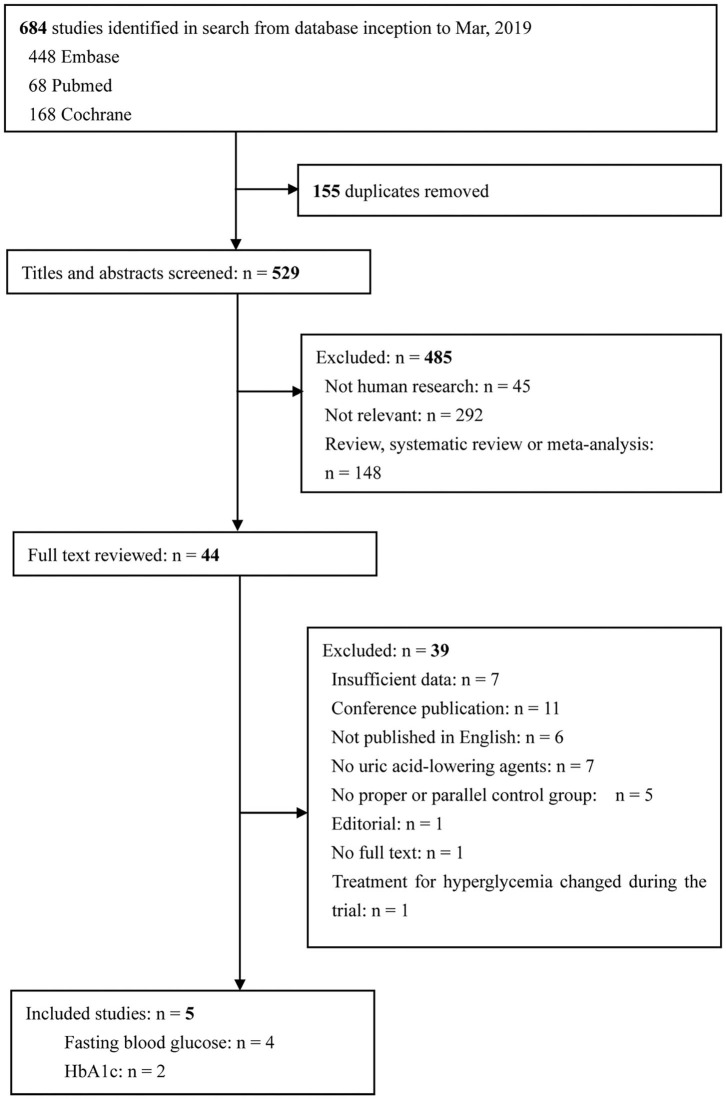
Flow diagram of study selection. Finally, five articles were included in the present study. Among these articles, three researches provided data on FBG, one research provided data on HbA1c, and another research provided both FBG and HbA1c data. FBG, fasting blood glucose; HbA1c, glycated hemoglobin A1c.